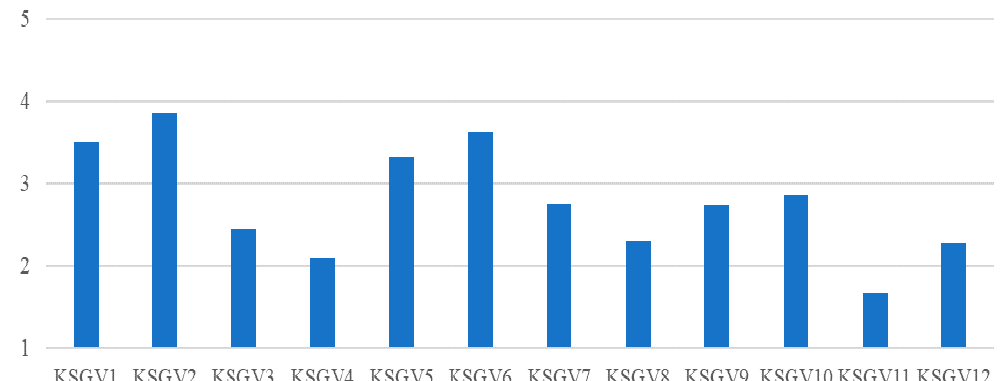
Figure 3. Type of knowledge about situations of gender-based violence. KSGV = “Knowledge of Situations of Gender-based Violence”.